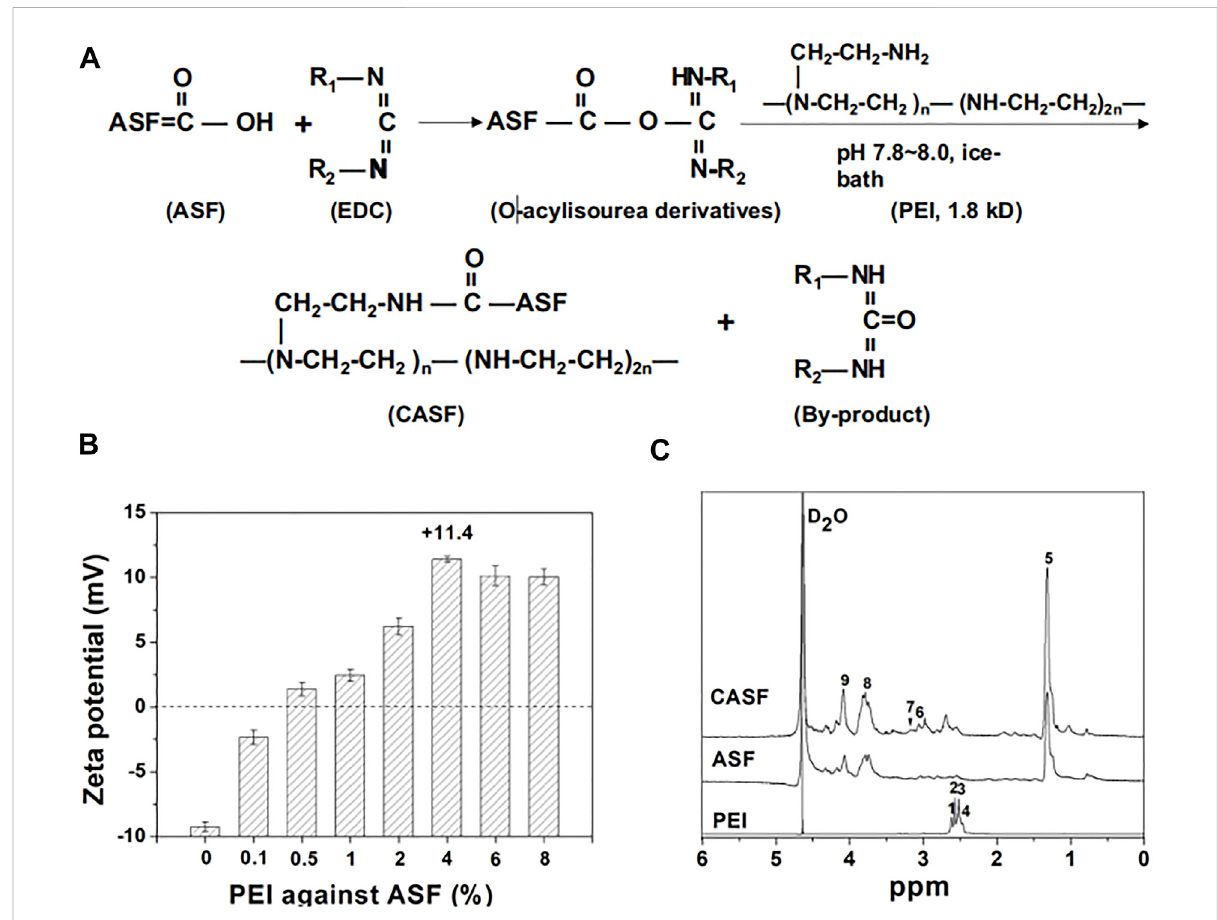
FIGURE 3 Synthesis and characteristics of CASF. (A) Schematic diagram of CASF synthesis. (B) Zeta potential of CASF at PEI/ASF weight ratios of 0%, 0.1%, 0.5%, 1%, 2%, 4%, 6%, and 8%. (C) 1 H-NMR spectra of PEI, ASF and CASF in D2O. Abbreviations: CASF, cationic Antheraea pernyi silk fi broin; PEI, polyethylenimine;ASF, Antheraeapernyi silk fifi broin;NMR,nuclearmagneticresonance.Notes:Qu,J.,Wang,W.,Feng,Y.,Niu,L.,Li,M.,Yang,J.,Xie, Y., 2019. Cationic Antheraea pernyi silk fi broin-modi fi ed adenovirus-mediated ING4 and IL-24 dual gene coexpression vector suppresses